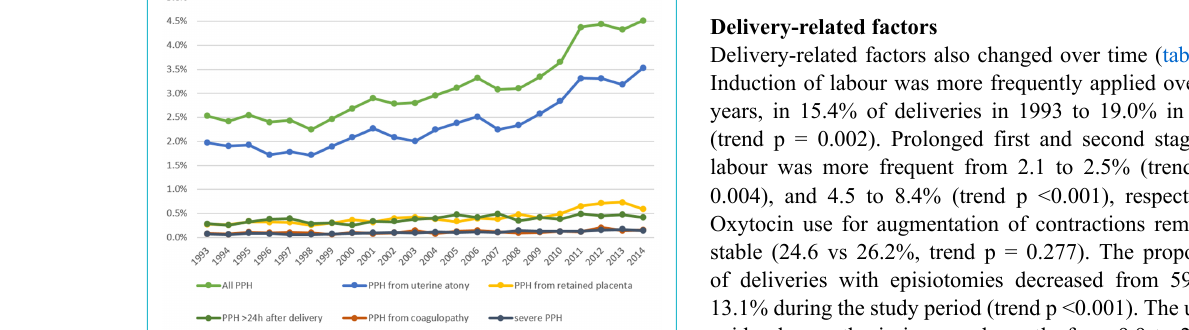
Figure 1: Incidence of postpartum haemorrhage over the 22-year period. Trends in the rate of postpartum haemorrhage (PPH) and haemorrhage by underlying aetiology from 1993 to 2014. The increase in all PPH was paralleled by a rise in uterine atony. Y-axis indicates the incidence (in %) and x-axis shows the corresponding year.